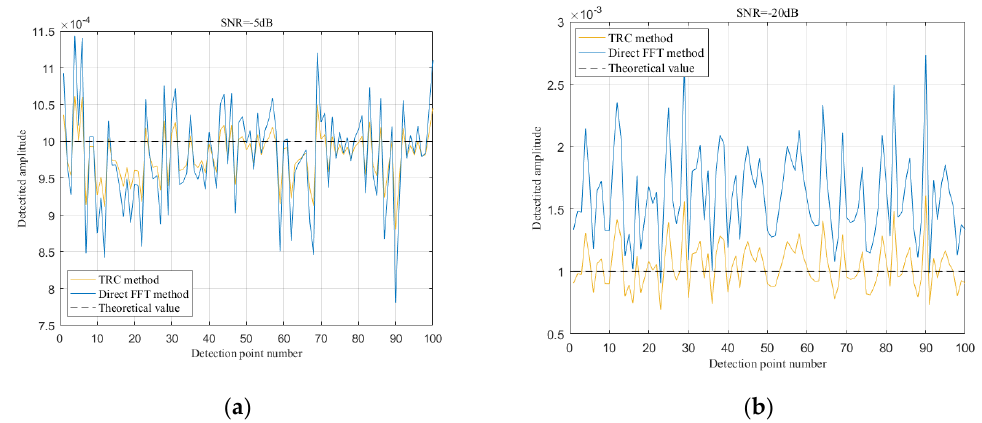
Figure 5. The amplitude detected by direct FFT method and TRC method under different SNR conditions. ( a ) When SNR = − 5 dB, detected amplitude values of V ( t ); ( b ) When SNR = − 20 dB, detected amplitude values of V ( t ).